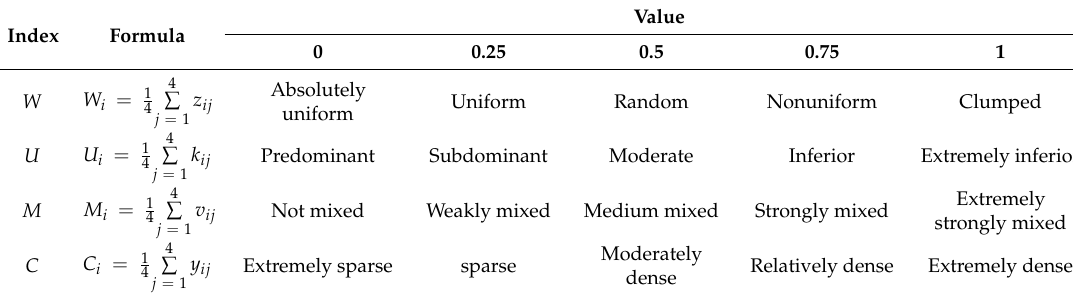
Table 2. Definitions and values for each spatial structure